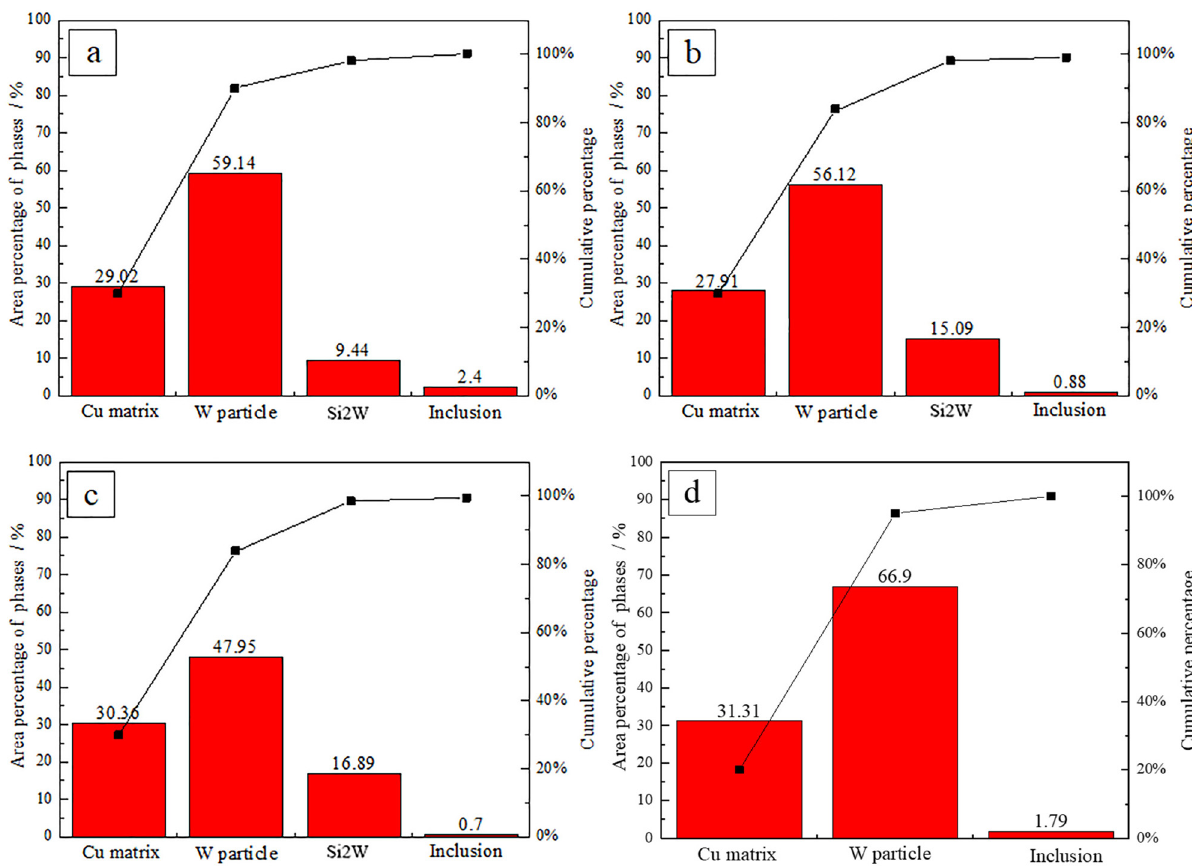
Figure 5: Phase distribution of the CuW composites prepared with di ff erent R ( C/A ) ( a: 0, b: 0.2, c: 0.6, d: 1.0 )